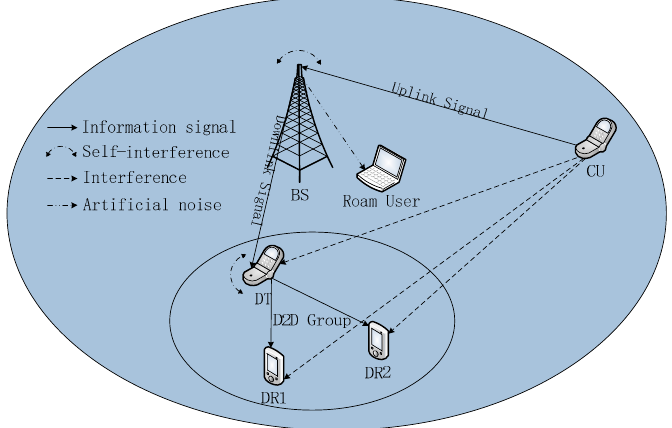
Figure 1. Full-duplex (FD) non-orthogonal multiple access (NOMA)-based simultaneous wireless information and power transfer (SWIPT) with the device-to-device (D2D) communications network model with one multiple-antennas base station (BS), four half-duplex (HD) single-antenna trusted users and one HD untrusted user.